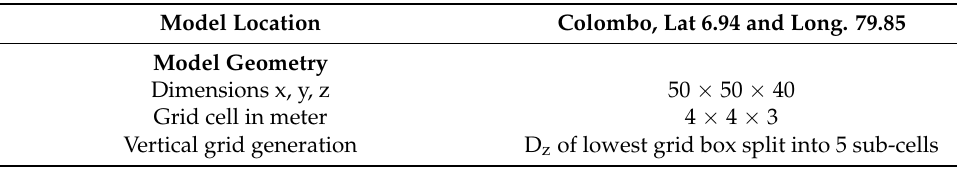
Table 12. ENVI-met input parameters for the